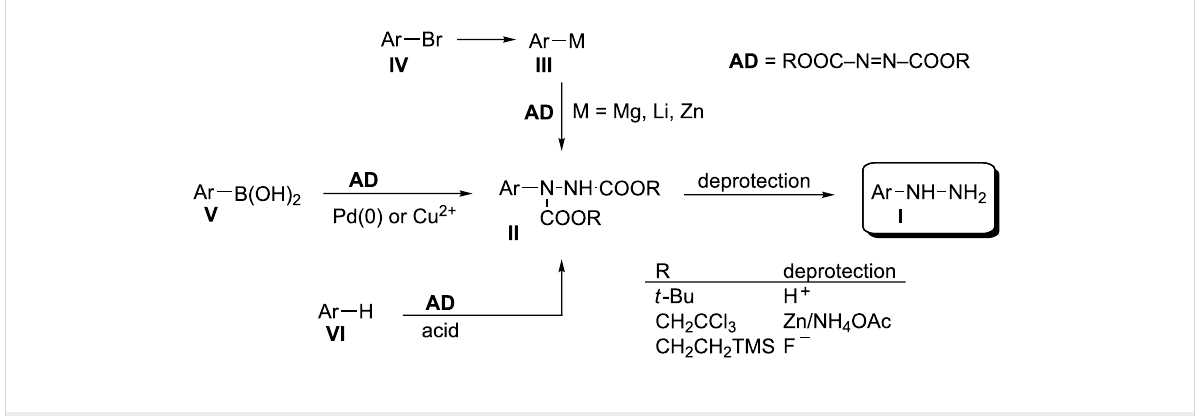
Figure 1: Selected methods for the preparation of arylhydrazines I through hydrazides II .